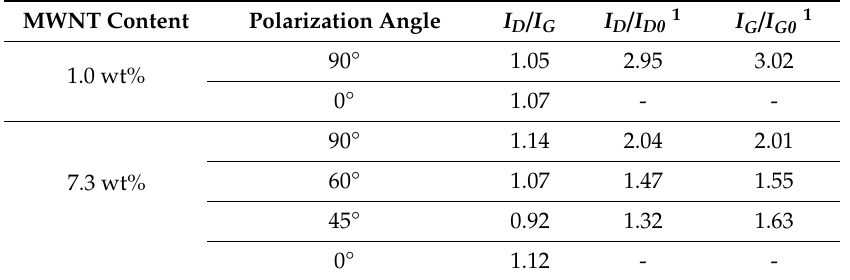
Table 1. Polarized Raman intensities of MWNT / PDMS composites by circumferential shearing process. MWNT